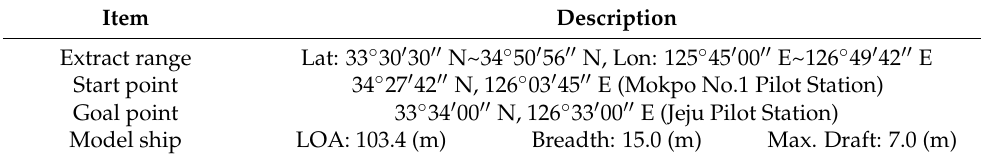
Table 3. Details of the simulation target area and ship model.